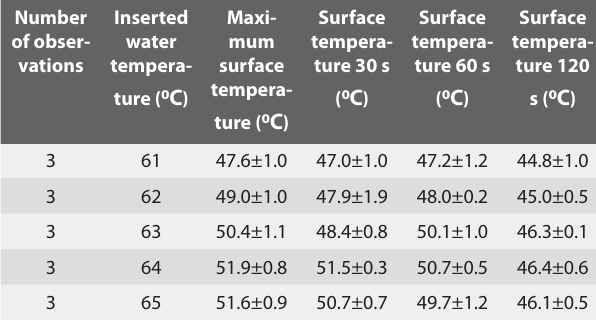
Table 2. Overview of Rapid Rhino®